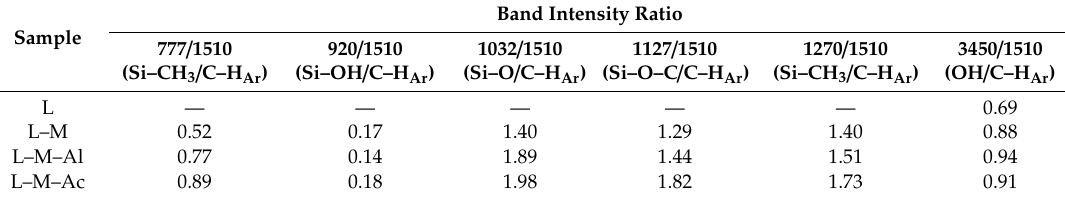
Table 4. Comparison of characteristic band intensity to basic bands observed of FT-IR spectra for lignin silanized with